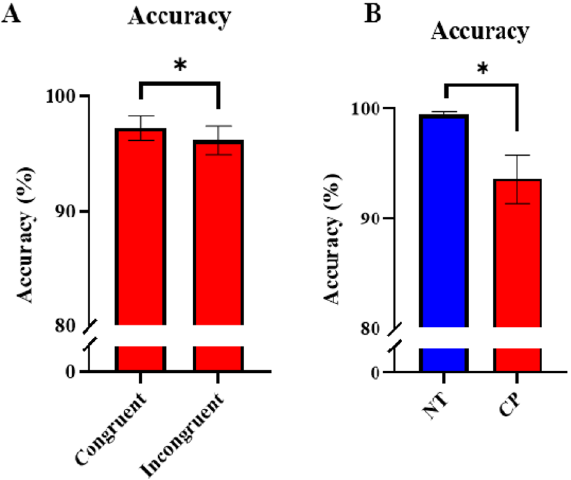
Figure 2. Accuracy between groups and conditions in the flanker task. ( A ) Accuracy (in %) was higher in the congruent versus the incongruent condition across all participants. ( B ) Accuracy was also higher in the neurotypical (NT) controls compared with the individuals with cerebral palsy (CP). Error bars reflect the standard error of the mean. *P <